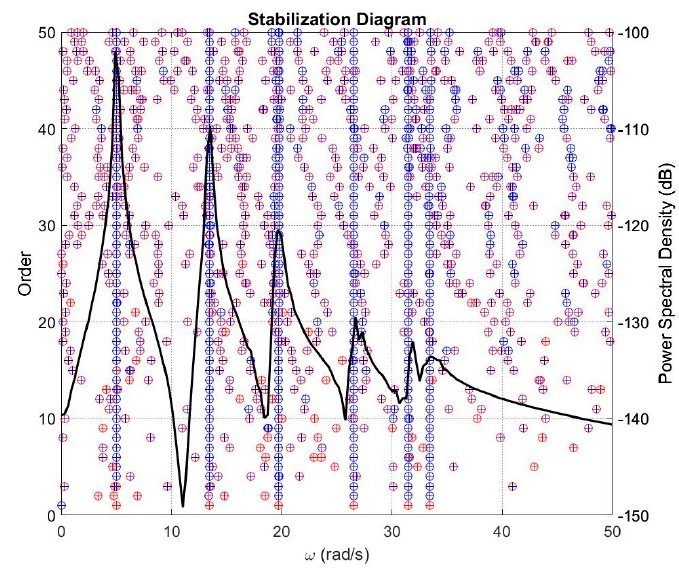
Figure 5. Stabilization diagram of six-DOF chain model of a cantilever beam.